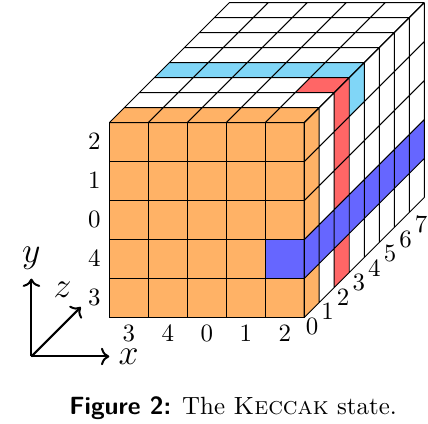
Figure 2: The Keccak